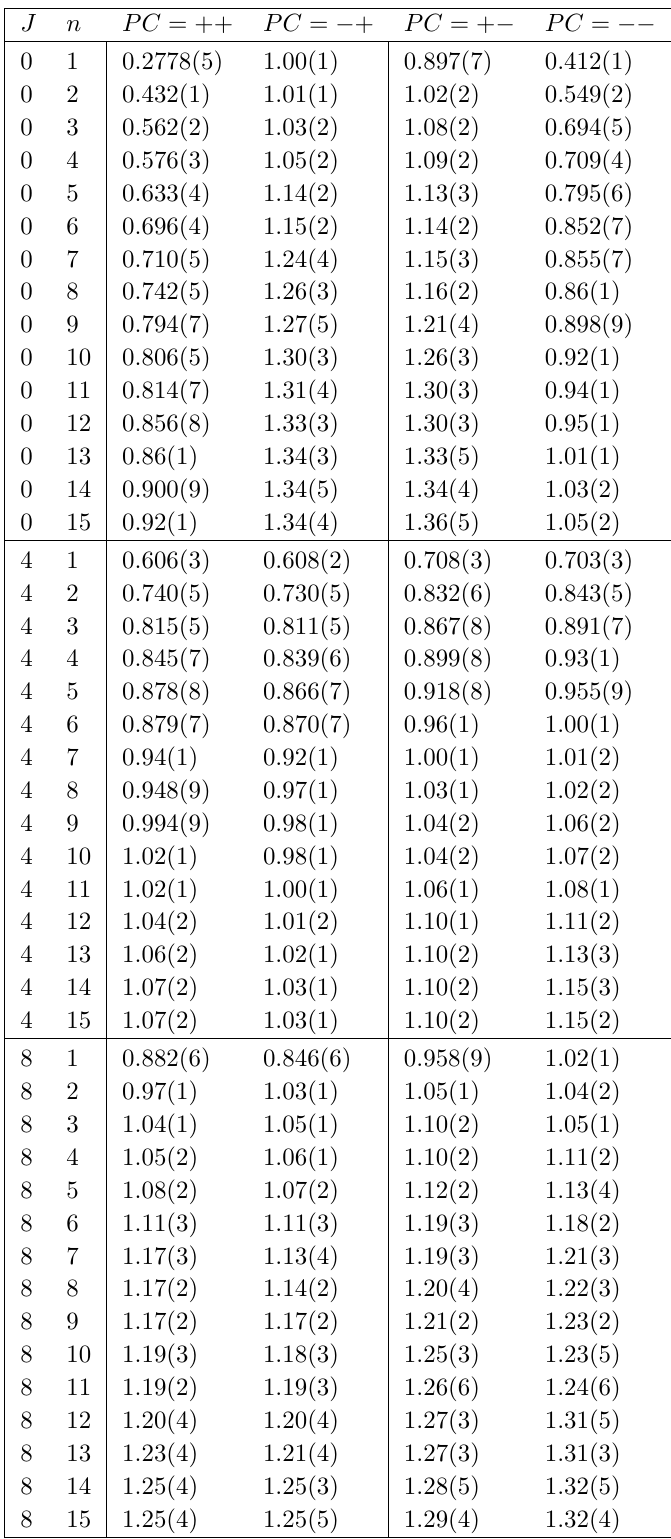
Table 4. Masses (in lattice units) for glueballs in A 1 and A 2 representations of Z 4